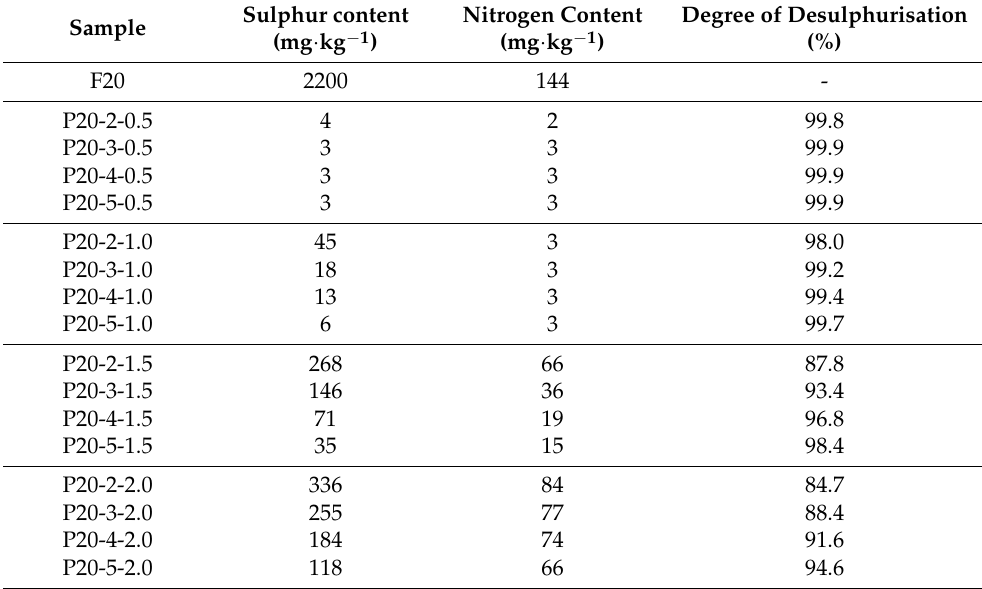
Table 7. The sulphur and nitrogen contents in the F20 feedstock and the P20 liquid